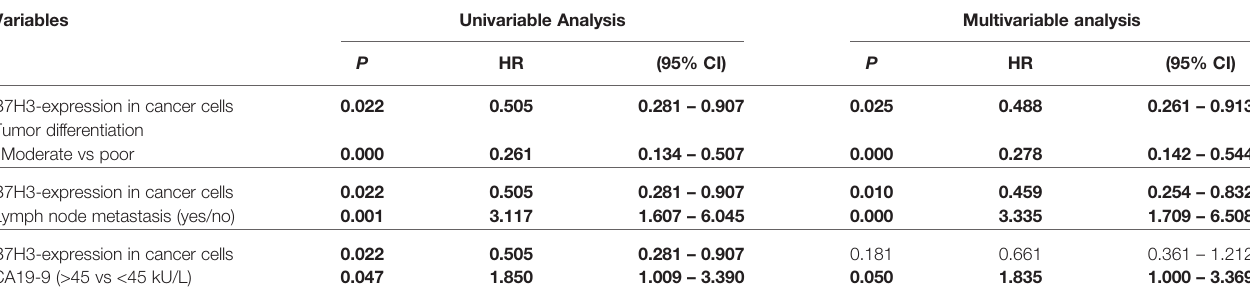
TABLE 4B | Cancer cell B7-H3 expression and tumor differentiation or Lymph node metastasis or